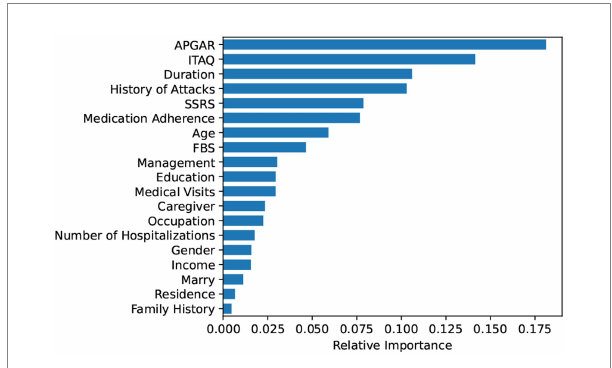
FIGURE 3 Rank of feature importance obtained by random